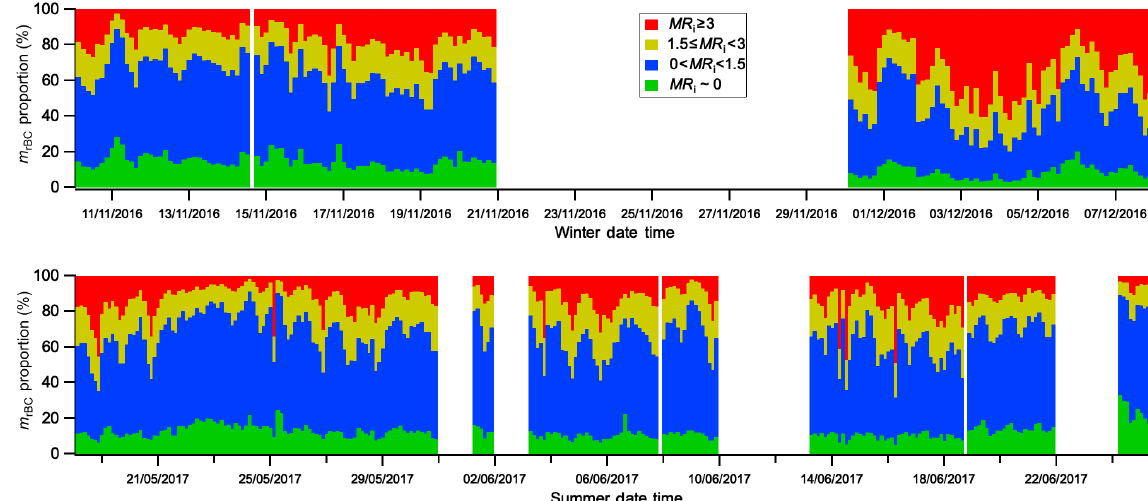
Figure 9. The evolution of rBC material mass fraction at a different single-particle MR (MR i ) level for winter and